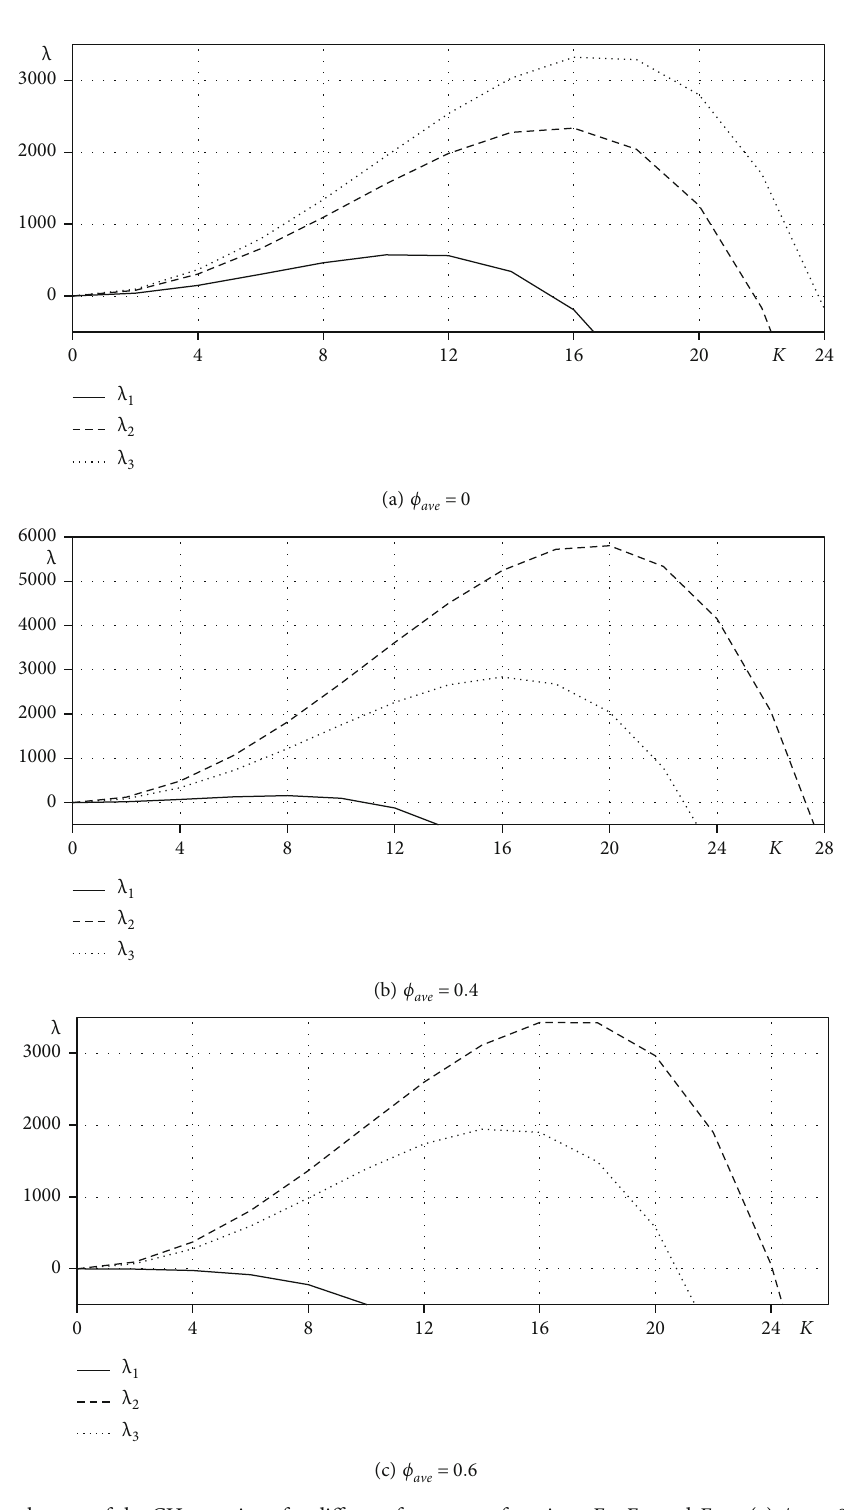
, F , and F at (a) ϕ = 0 , (b) ϕ = 0 : 4 , and (c) 1 2 3 ave ave